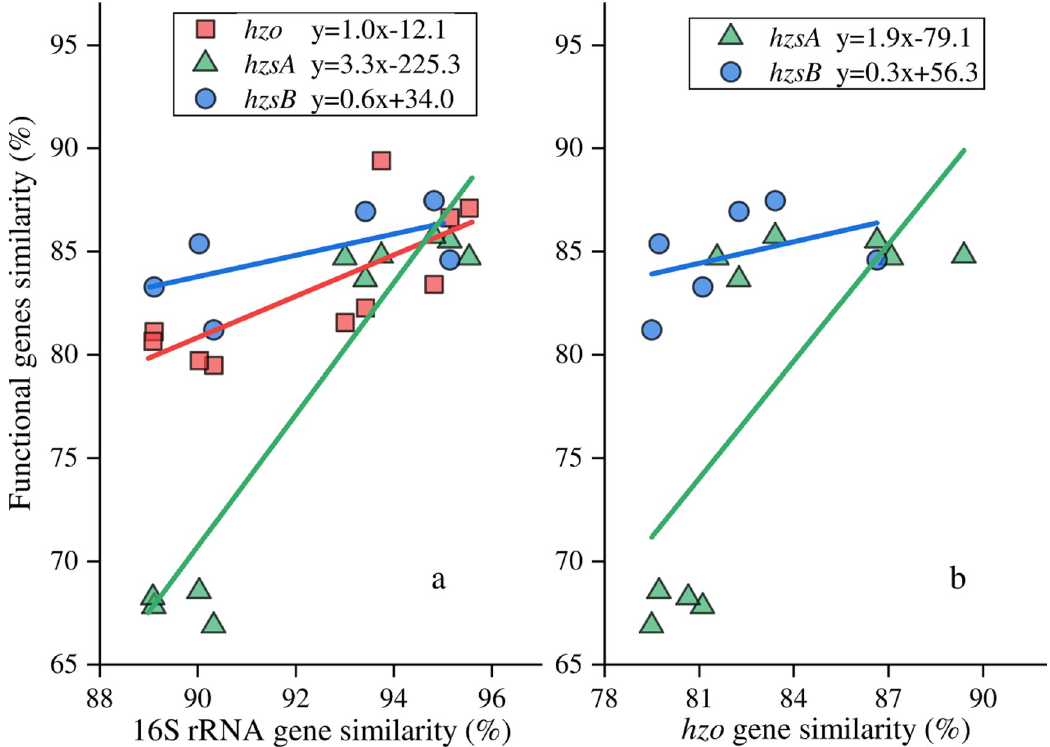
Fig 1. Pairwise nucleotide identity comparisons of functional and 16S rRNA genes of the 5 known genera.